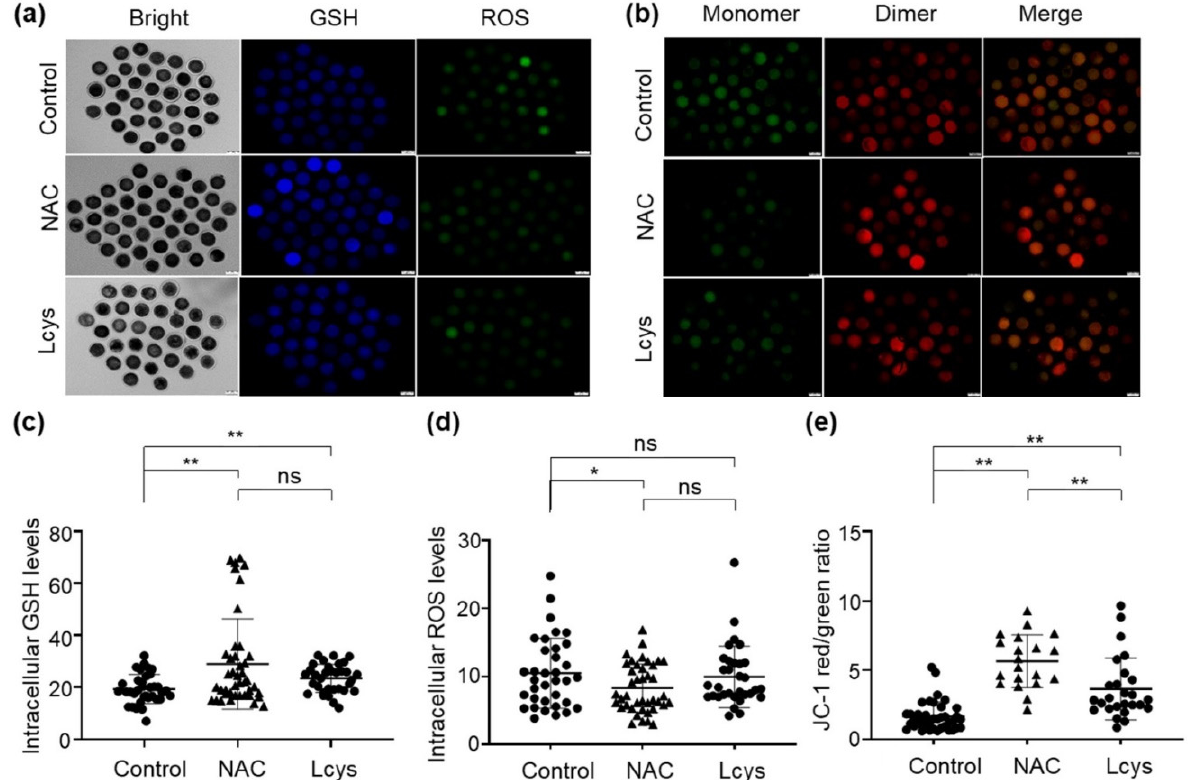
Figure 2. Supplementation of NAC increases the quality of in vitro mature oocytes. Intracellular GSH, ROS levels ( a ) and mitochondrial membrane potential ( b ) of oocytes incubated in medium with or without NAC (1 mM) and L-cysteine (0.6 mM). Images were analyzed by an inverted two-deck microscopy system (IX83, Olympus, Japan) with identical fluorescence parameters. Normal mitochondrial membrane potential is visualized in red with JC-1 dimers and depolarized membrane potential is shown in green with JC-1 monomers. Fluorescence signal of GSH ( c ), ROS ( d ) and mitochondrial membrane potential ( e ) in the images were quantified by using the ImageJ software. Scale bars = 100 µ m. NAC, N-acetyl-L-cysteine; Lcys, L-cysteine; GSH, reduced glutathione; ROS, reactive oxygen species. Values are means ± SEM calculated from three replicates; ns, no significant difference; *, p < 0.05; **, p < 0.01.